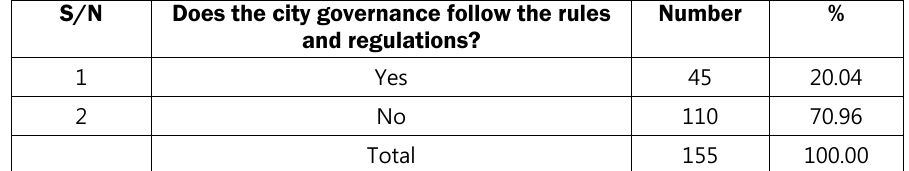
TABLE 8: Citizens’ response about compliance of government directions by the M.C. Sirsa S/N Does the city governance follow the rules and